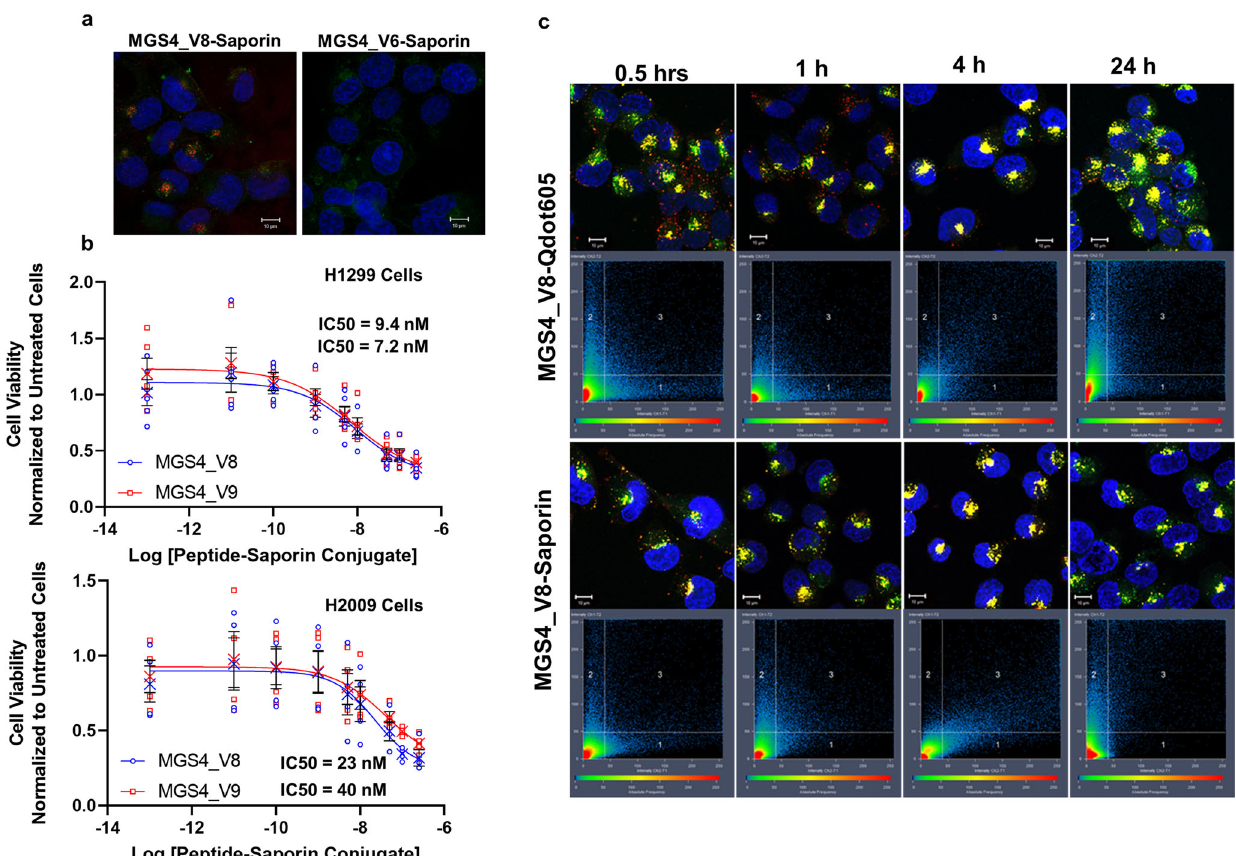
Fig. 4 MGS4_V8 effectively delivers active saporin to cancer cells. a H1299cells were incubated biotinylated MGS4_V8 conjugated to streptavidin-saporin for 1h, then washed, fi xed and counterstained with an anti-saporin antibody (red), WGA-AF488 (green) and DAPI (blue). MGS4_V8 successfully delivers saporin into cancer cells while the control peptide, MGS4_V6 cannot. b MGS4_V8 and MGS4_V9 saporin-conjugates were serially diluted and incubated with H1299 and H2009 cells for 6h after which, the MGS4-saporin conjugates were removed and complete growth media returned to the wells. At 72h, viability was measured.IC50 values are provided intheinset.Individualmeasurementsareshown.The mean isshown asan “ X ” . Error bars, inblack, represent standard error measurements. Non-linear regression analysis is included in the supplementary material. c Colocalization time course as before, comparing MGS4_V8- streptavidin-Qdot traf fi cking to MGS4_V8-saporin traf fi cking. Pixels are plotted based on intensity in the red channel (x-axis) and the green channel (y-axis). Box 1 represents the population of saporin or Qdots not colocalized with the lysosome. Conversely, box 2 represents lysosomal staining not associated with Qdots or saporin signal. Box 3 contains colocalized pixels, which are falsely colored yellow and represent saporin or Qdots colocalized within the lysosomal compartment. A subpopulation of saporin containing vesicles remain distinct from lysosomes (box 1). The scale bar in all images represents 10 µ m.